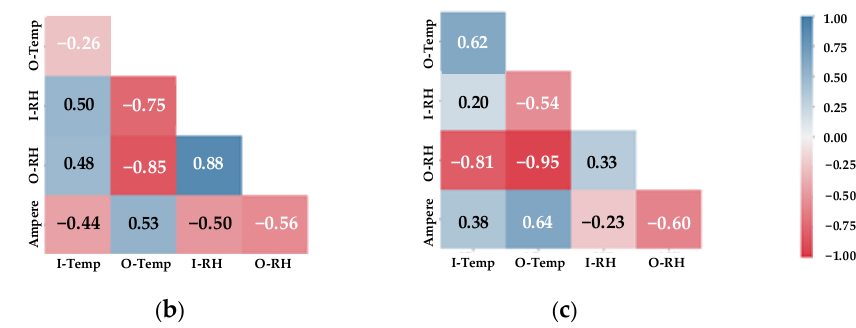
Figure 4. Thermal comfort correlations based on indoor environment, outdoor environment, and HVAC system : ( a ) good condition; ( b ) bad condition; ( c ) worst condition